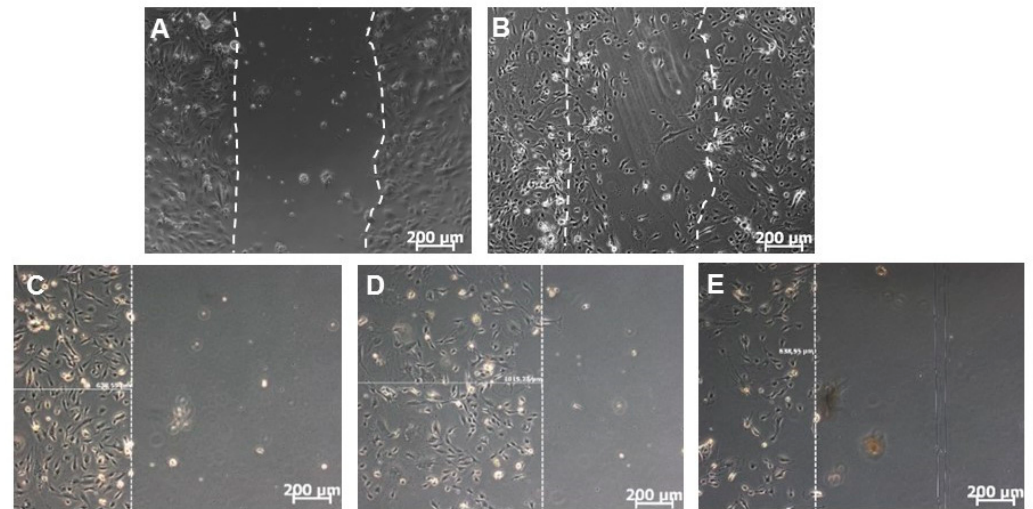
Figure 7. Comparison of conventional scratch assay versus scratch device. Cells were scratched with a 100 µL pipette tip ( A ) and cells migrated into the scratch within 24 h ( B ). By using the device, a clear and linear scratch was created ( C ) and the cells migrated into the scratch within 24 h ( D ). After the migration, the cells were re-scratched and collected at the same position ( E ).